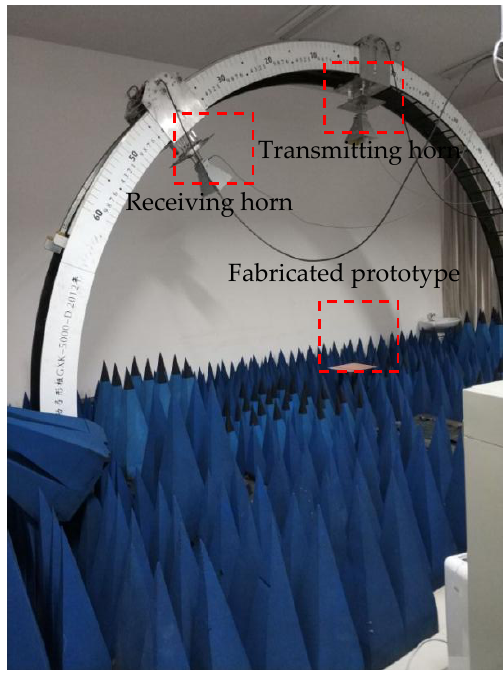
Figure 12. Measurement setup.